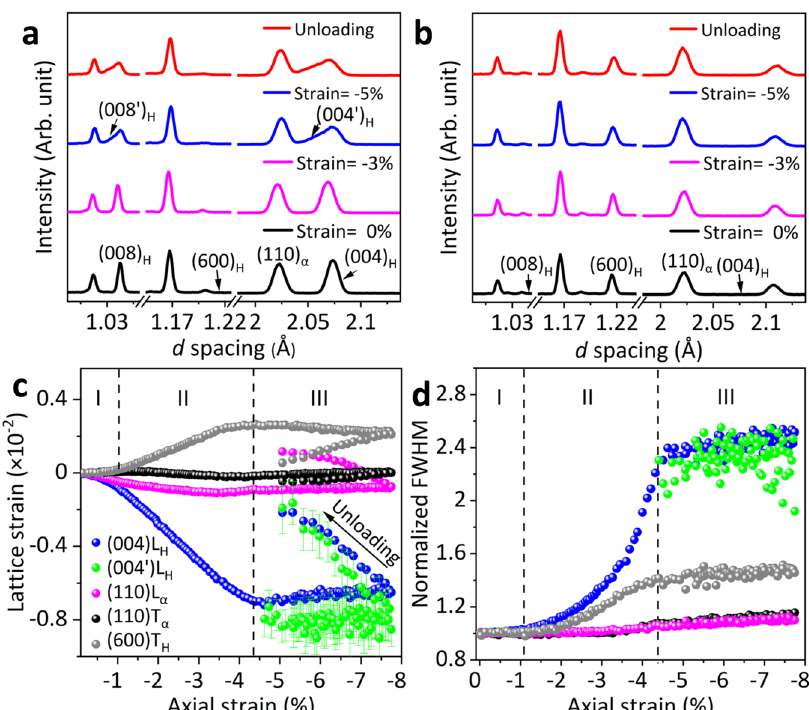
Fig. 4 Real-time in-situ neutron diffraction studies of S-4 alloy. a , b In-situ neutron diffraction pro fi les at the strain of 0%, − 3%, − 5%, and unloading stage collected in the LD ( a ) and TD ( b ), respectively, correspond to I, II, and III stages. c , d Lattice strains ( c ) and normalized peak FWHMs ( d ) in LD and TD versus applied compressive strain,